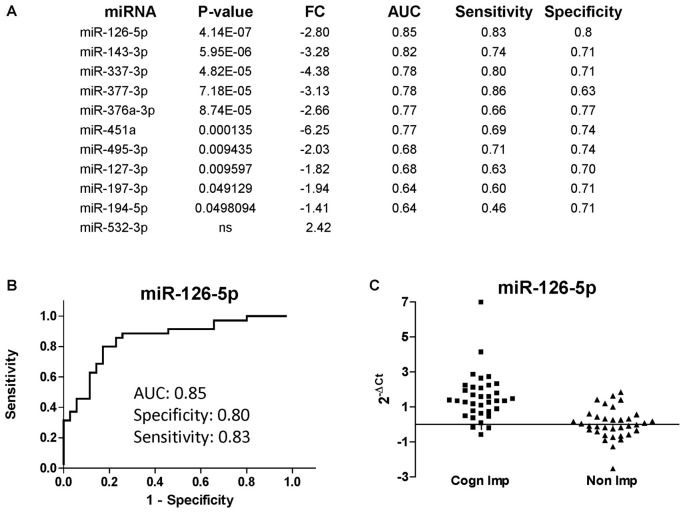
miRNAs discriminating CI from non-impaired PLWHA at CHARTER. (A) List of miRNAs associated with cognitive impairments (CI, n = 35; non-CI, n = 35), ordered according to the best P-value. Relative expression (FC, fold change), AUC, sensitivity and specificity are indicated for each miRNA. Note that miR-532-3p was the only upregulated miRNAs, but the difference was not statistically significant. (B) ROC analysis of the best miRNA biomarker, miR-126-5p. (C) Scatter plot showing relative expression of miR-126-5p in the two groups of CI and non-impaired patients.